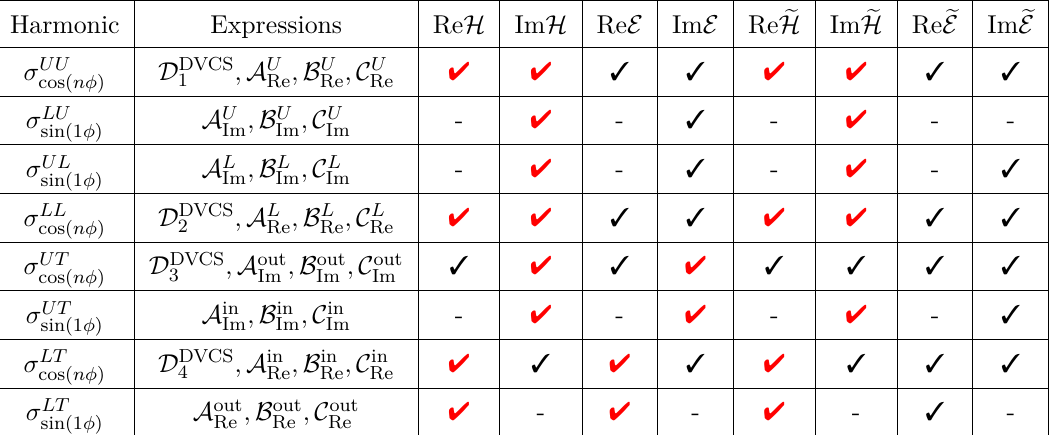
Table 3. A list of the CFF content of each of the leading twist harmonic cross sections. Cells containing larger, red check marks indicate a stronger dependence on that CFF, while the smaller black check marks indicate subdominant terms in the cross